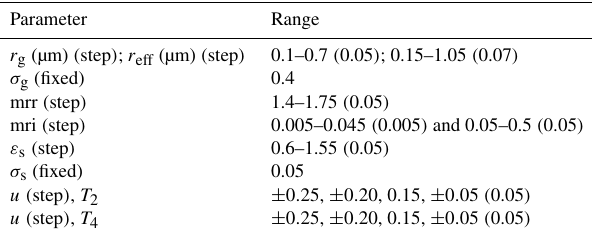
Table 1. The parameters used for the generation of the look-up ta- bles of the near-spherical and Chebyshev